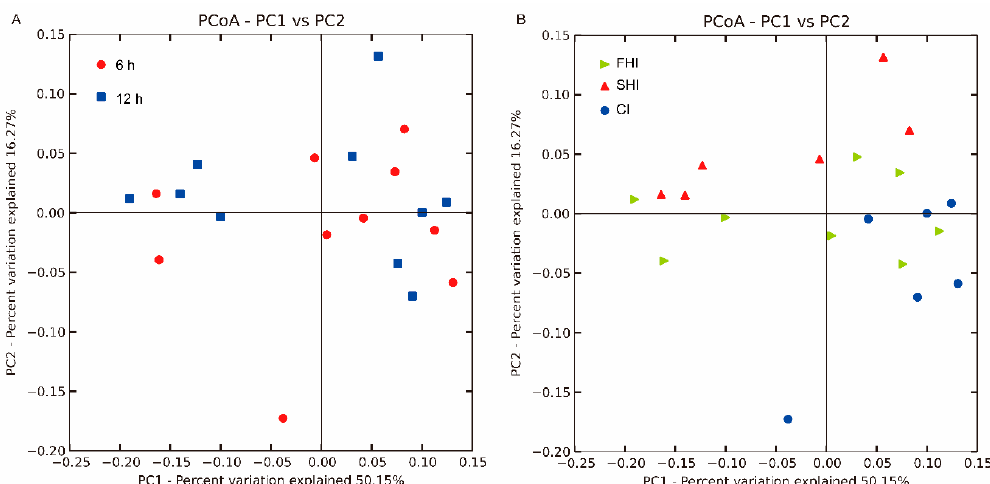
Figure 3. Principal coordinate analysis (PCoA) of the in vitro bacterial community. A , The comparison between sampling time. B , The comparison among treatments. 6 h, sampling at 6 h after feeding; 12 h, sampling at 12 h after feeding. FHI, first half infusion of maltodextrin; SHI, second half infusion of maltodextrin; CI, continuous infusion of maltodextrin.